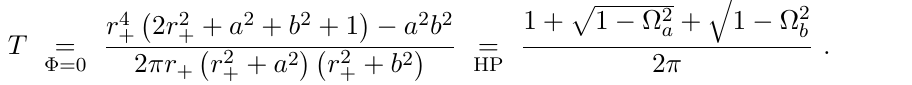
Figure 2 . Gibbs’ free energy G as function of the temperature T . The electric potential vanishes Φ = 0 and the angular velocities increase from right to left as Ω cusp moves “North-West” as angular velocities increase, staying above the minimum temperature T min = 1 ≈ 0 . 16 even in the limit Ω a = Ω b → 1 2 π